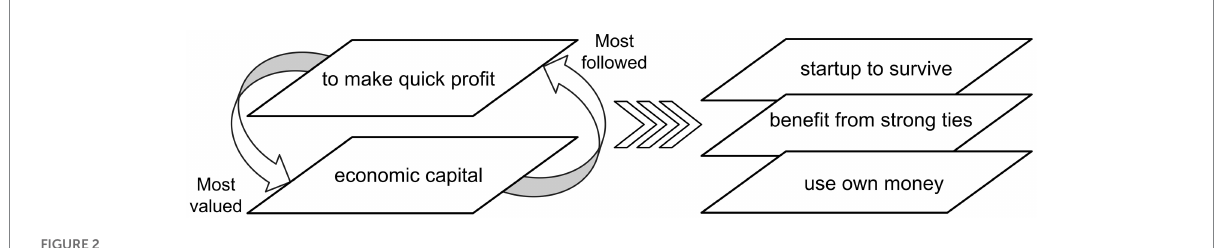
FIGURE 2 Entrepreneurship practice patterns (heteronomous phase: